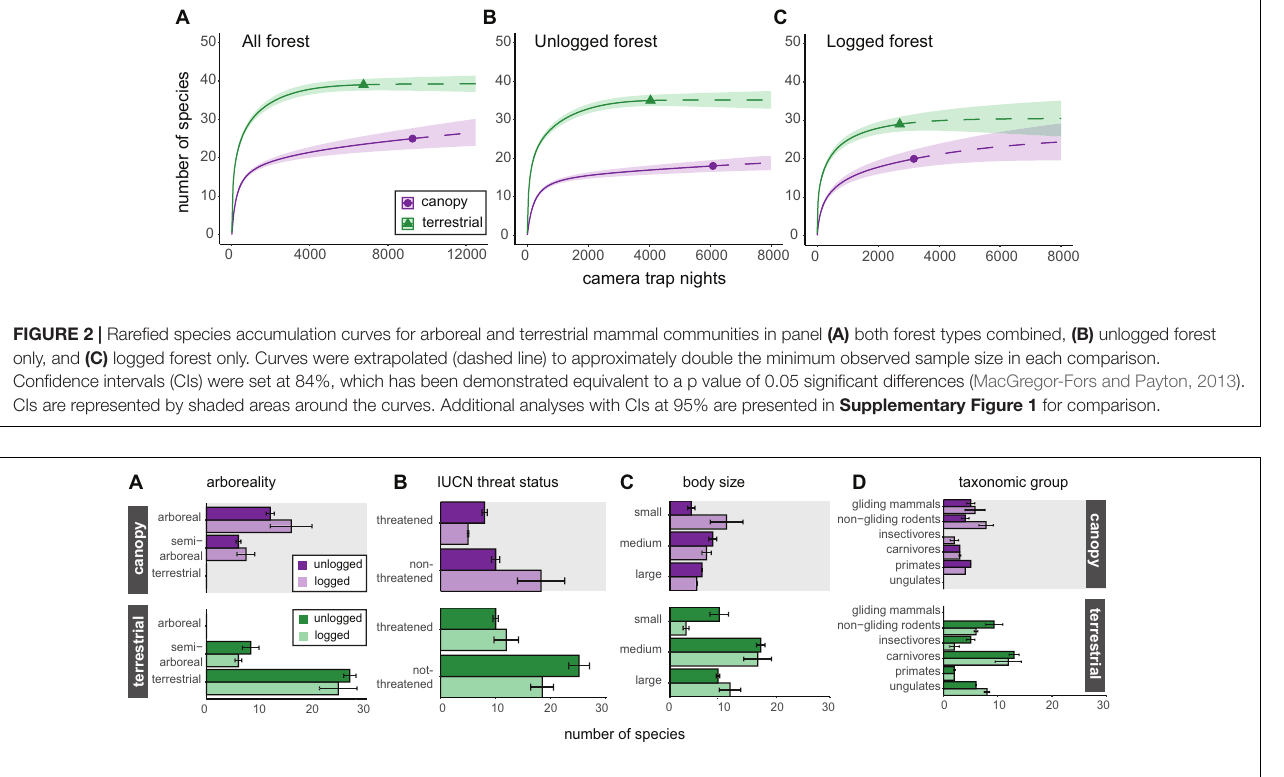
FIGURE 3 | Number of species detected by canopy and terrestrial camera-traps in logged and unlogged forest, split into groups according to panel (A) arboreality, (B) IUCN threat status, (C) body size and (D) taxonomic group. Richness data were extracted from rarefied species accumulation curves at a common sample size, together with 84% confidence